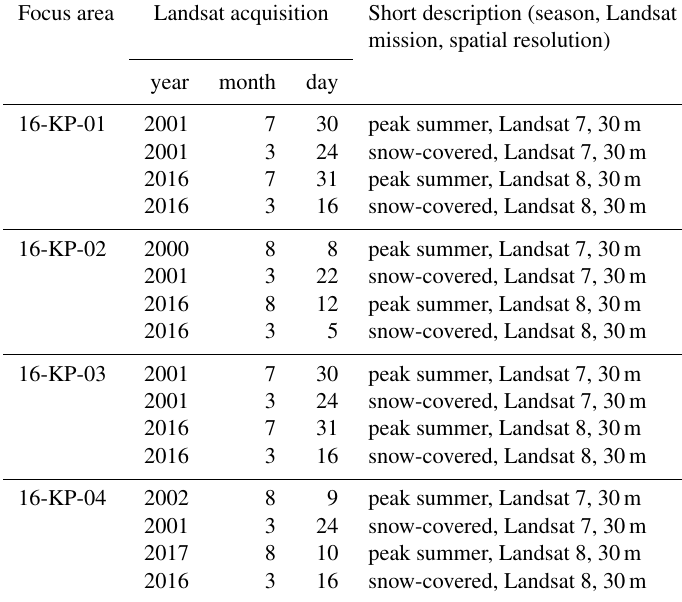
Table B1. Dates and short description of Landsat data used for retrieving spectral indices and further land-cover classification (in Shevtsova et al.,